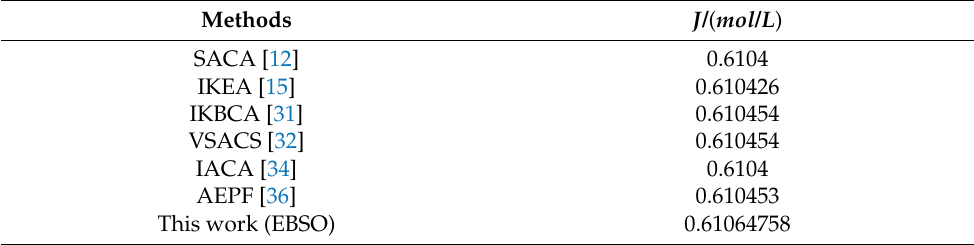
Table 6. Comparison of methods of batch reactor ( N =